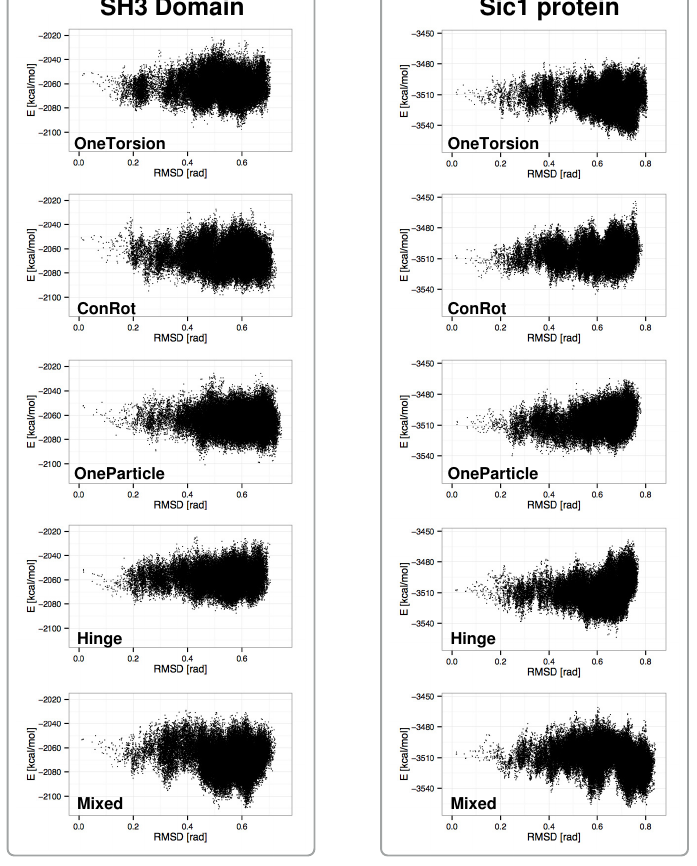
Figure 3. Projection of sampled states on distance vs. energy plots for the SH3 domain and the Sic1